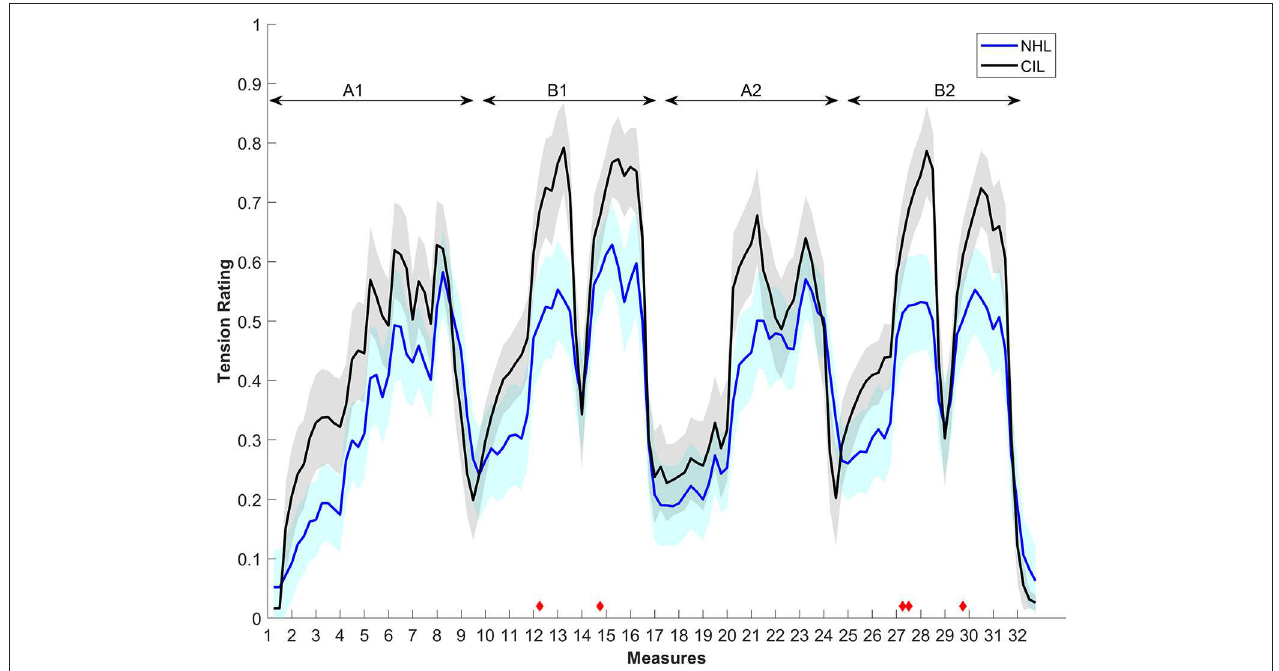
FIGURE 1 | Average tension ratings of 8 CIL (in black) and 9 NHL (in blue) as a function of the musical measures of the non-modified piece (baseline). Shaded areas represent standard errors. Red diamonds indicate the period in which the two ratings differ significantly. Horizontal double arrows outline the 4 parts of the piece (A1, B1, A2,